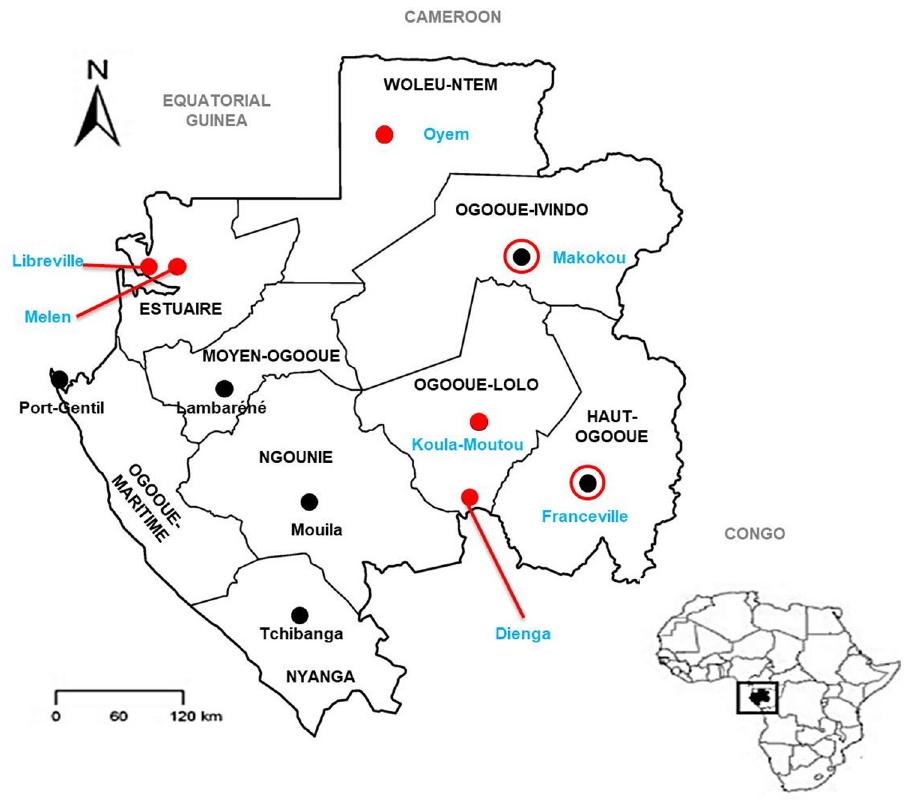
Fig 4. Study sites where samples were collected. Map of Gabon with the names of the nine (9) provinces. The black dots on the map correspond to the capitals of each province. Red circles represent many villages around the site, and red full stops indicate a site. Libreville, Oyem and Koula-Moutou are represented in red full stop to indicate study sites but are also capitals of province. Blue indicates the names of sites that patients were recruited from for the present study. Map adapted from: